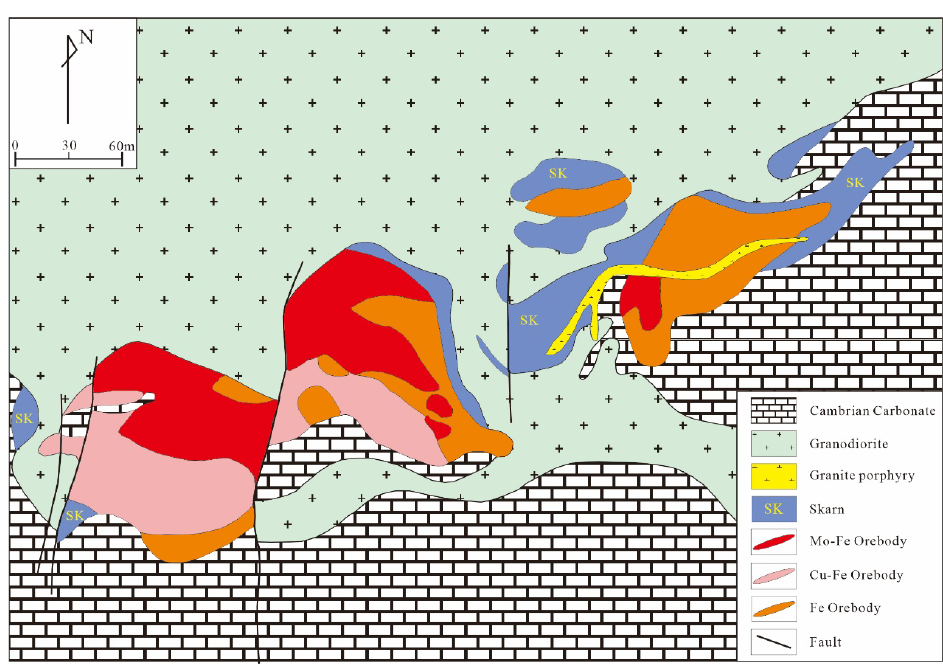
Minerals 2022 , 12 , x